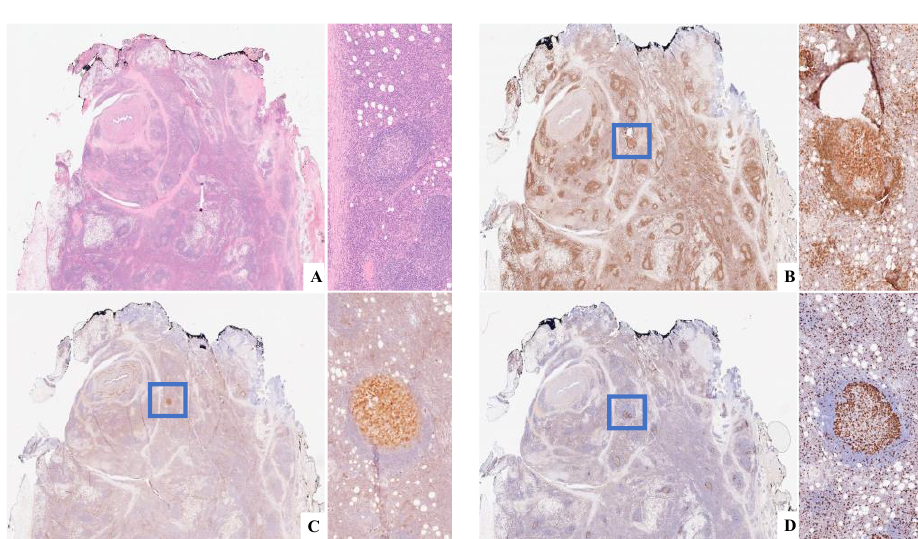
Figure 10. ( A ) H&E original magnification 4x ISFN highlighted in the blue rectangle. ( B ) BCL2+. ( C ) CD10+; ( D ) Ki-67.